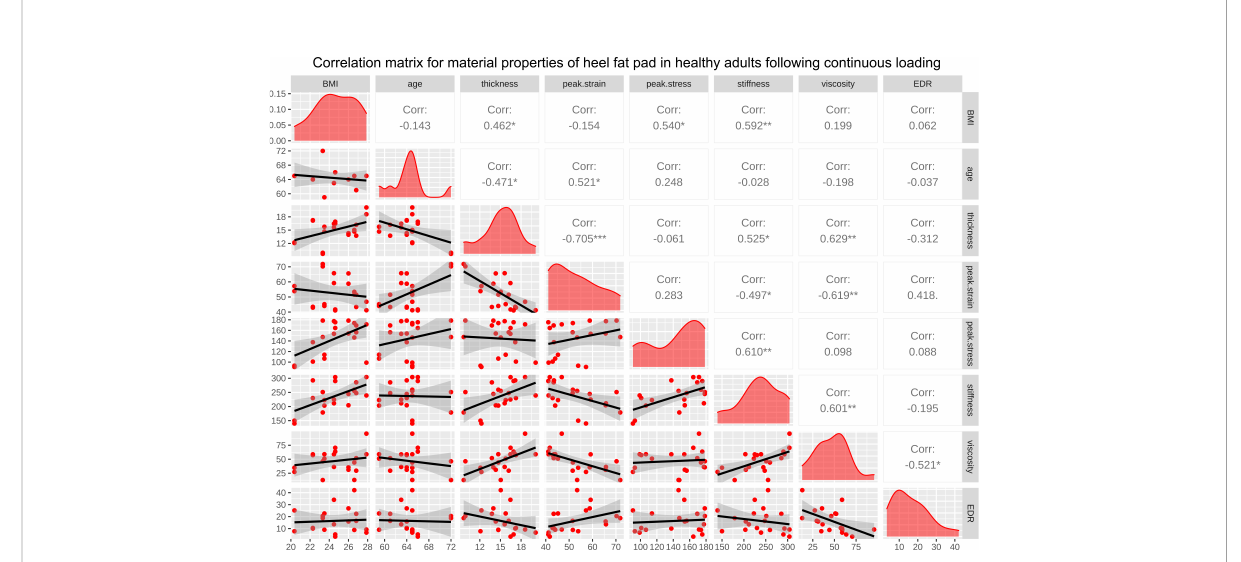
FIGURE 5 The correlation matrix for BMI, age, primary thickness, peak strain, peak stress, stiffness, viscous modulus, and EDR of heel in healthy adults following continuous loading. The values displayed in the right-upper triangle represent the Pearson ’ s correlation coef fi cients (R values). The lower-left triangle displays the scatter plots and regression lines. The plots on the diagonal line present the distribution density of the variables in the matrix. BMI: body mass index; EDR= energy dissipation rate. P values:.p<0.100, *p<0.050, **p<0.010,